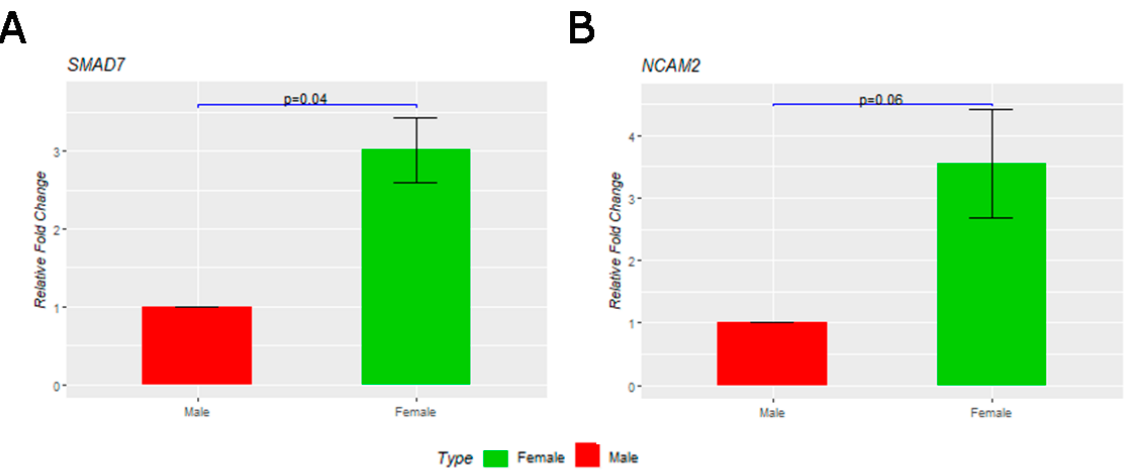
Figure 4. RT-qPCR validation of candidate differentially expressed genes in cultured male and female PGCs from a chicken layer breed. ( A ) The expression of the SMAD7 gene is significantly higher in female PGCs, with a p -value of 0.04. ( B ) The expression of the NCAM2 gene is higher in female PGCs than in male PGCs, with a p -value of 0.06.